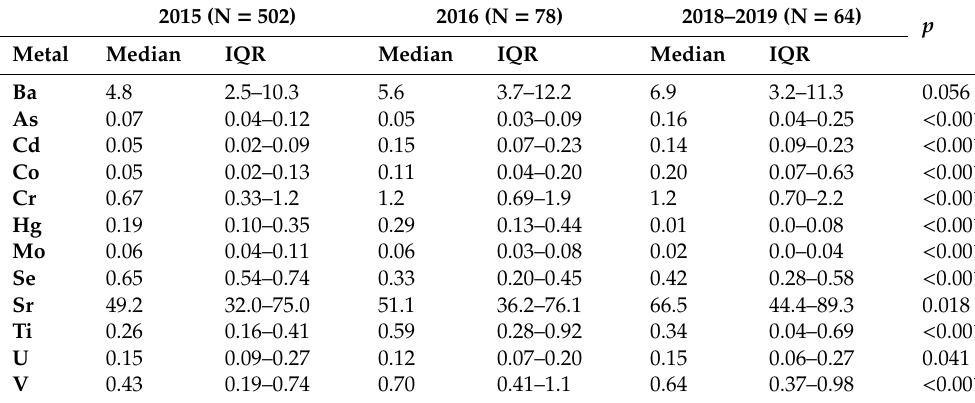
Table 5. Comparison of the median metal concentration in hair of the cohort of mothers by